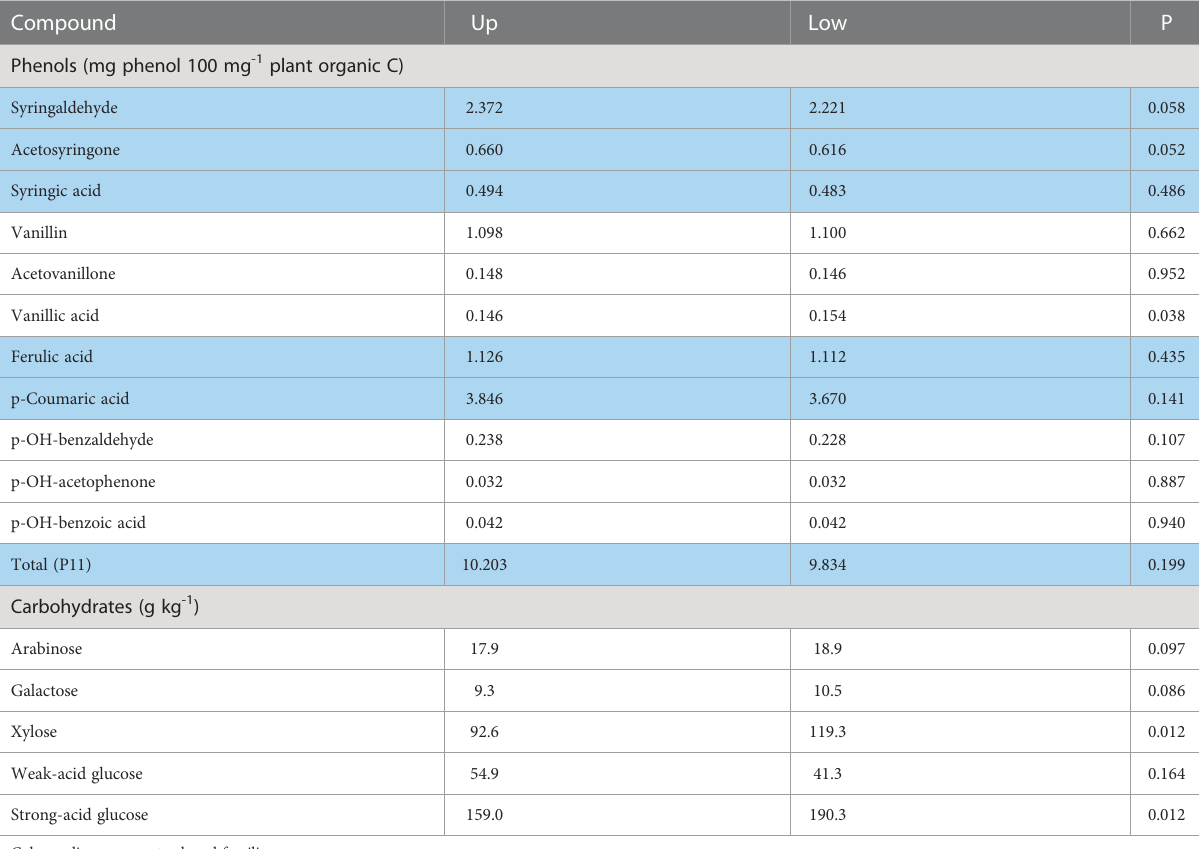
TABLE 2 Landscape means, averaged across the control andtwo humic producttreatments, for concentrations of phenoland carbohydrate compounds in maize roots for the 2014 growing season, for the upland(Up) and lowland (Low) transects, and the signi fi cance (P) of the landscape effect.